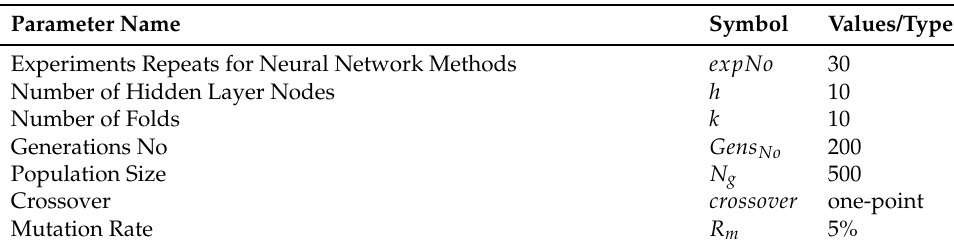
Table 1. ParameterSettings.